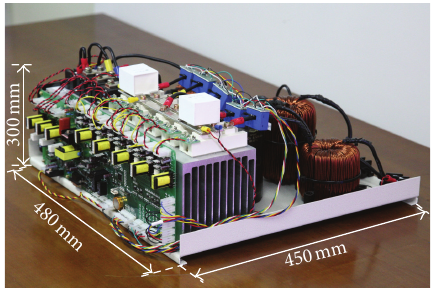
Figure 7: Photograph of 15kW prototype. Table 2: Parameters and specifications of the prototype.